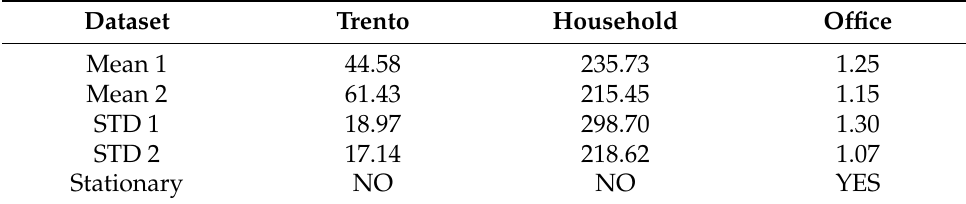
Table 1. Stationarity analysis results.